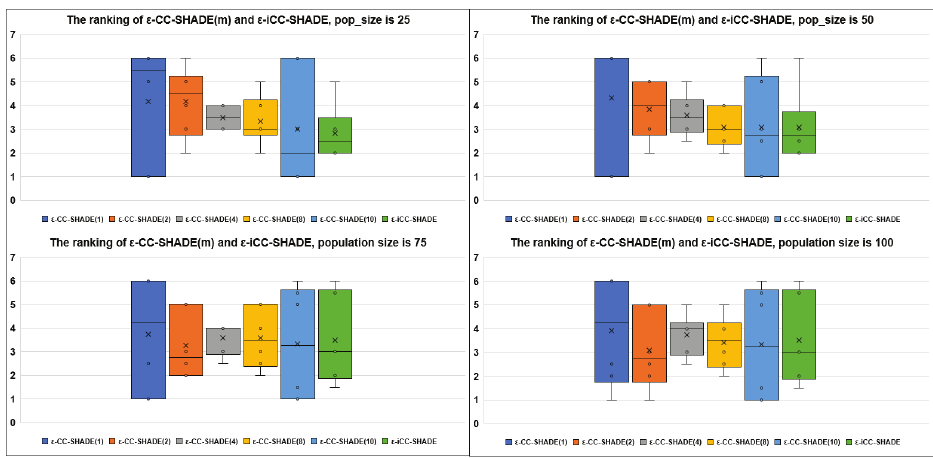
Figure 2. The ranking of ε -CC-SHADE (m) and ε -iCC-SHADE on non-separable problems.